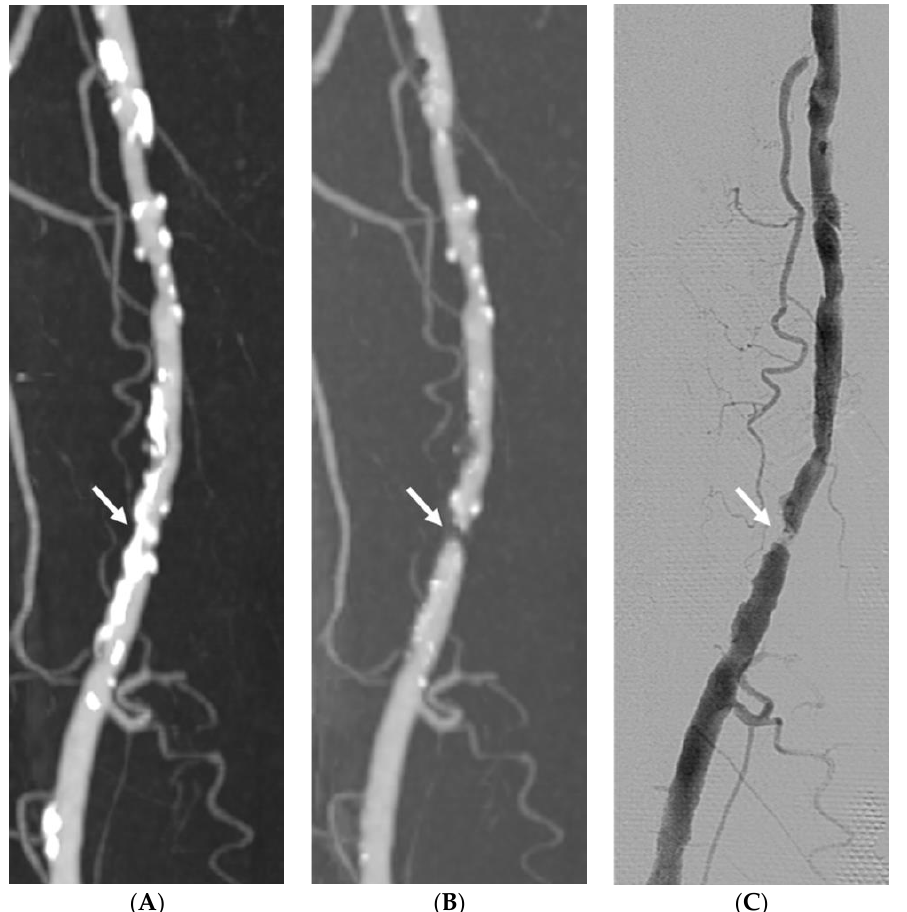
Figure 3. Imaging study of a 74-year-old man with claudication and severe vascular calcification in the right superficial femoral artery comparing dual-energy computed tomography (CT) standard reconstruction maximum intensity projection (MIP) image ( A ), automatic plaque removal MIP image ( B ), and the gold standard DSA ( C ). The automatic plaque removal maximum intensity projection (MIP) image reveals one hemodynamically significant stenosis (arrow) confirmed by DSA.